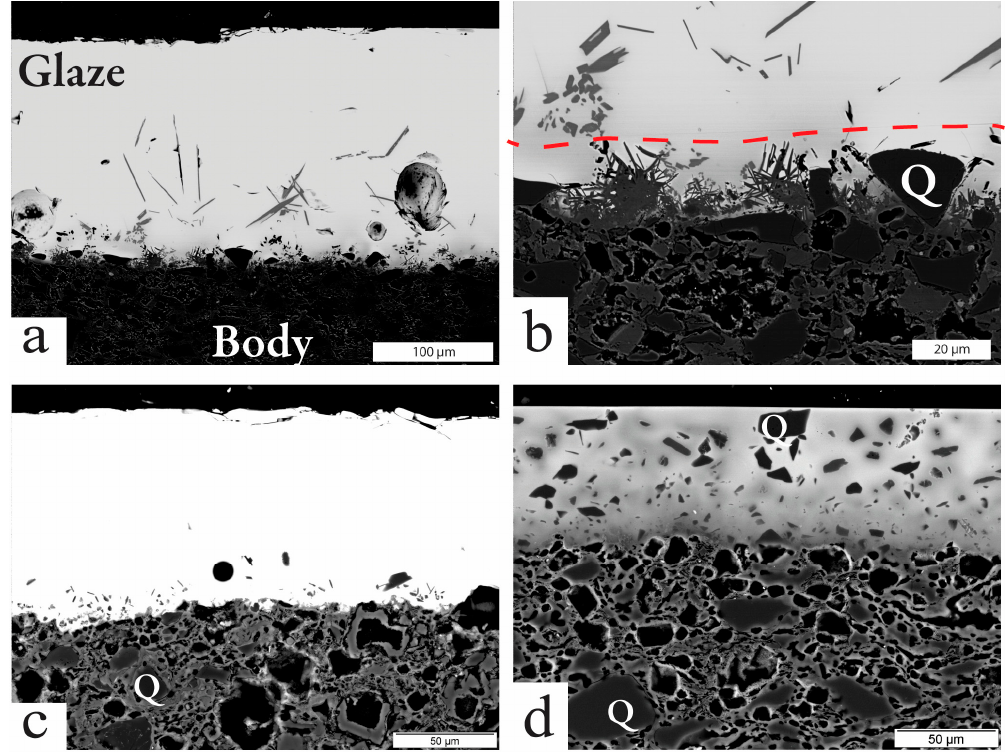
Figure 22. SEM-BSE images of Swiss lead glazes. ( a ) Macroscopically transparent glaze with many needle like crystals. Matzendorf, [19] (sample BER 15); ( b ) Close-up of ( a ) with the approximately 20 micron thick reaction zone (cluster of needle-like crystals and corroded body quartz in a glassy matrix) and the glaze with a few prismatic to acicular crystals. The dashed red line corresponds to the original (before firing) course of the contact between body and the glaze; ( c ) Macroscopically transparent glaze. Dortu, Carouge, 1813–1824, [37] (BER 13); ( d ) Macroscopically translucent glaze full of resorbed quartz grains. Poteries fines, Nyon, 1920–1923, [37] (NYO